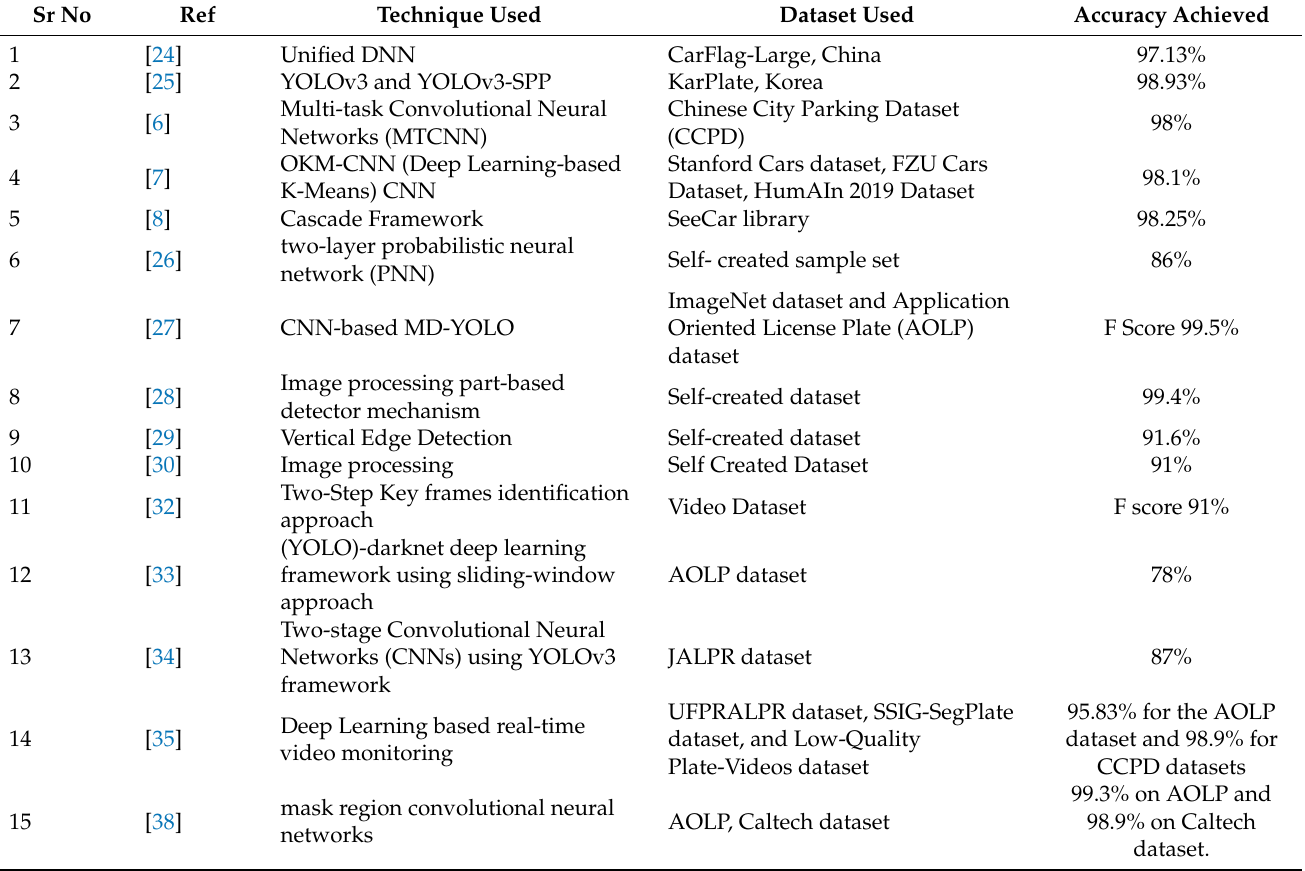
Table 1. Summary of the state-of-the-art research in ALPR